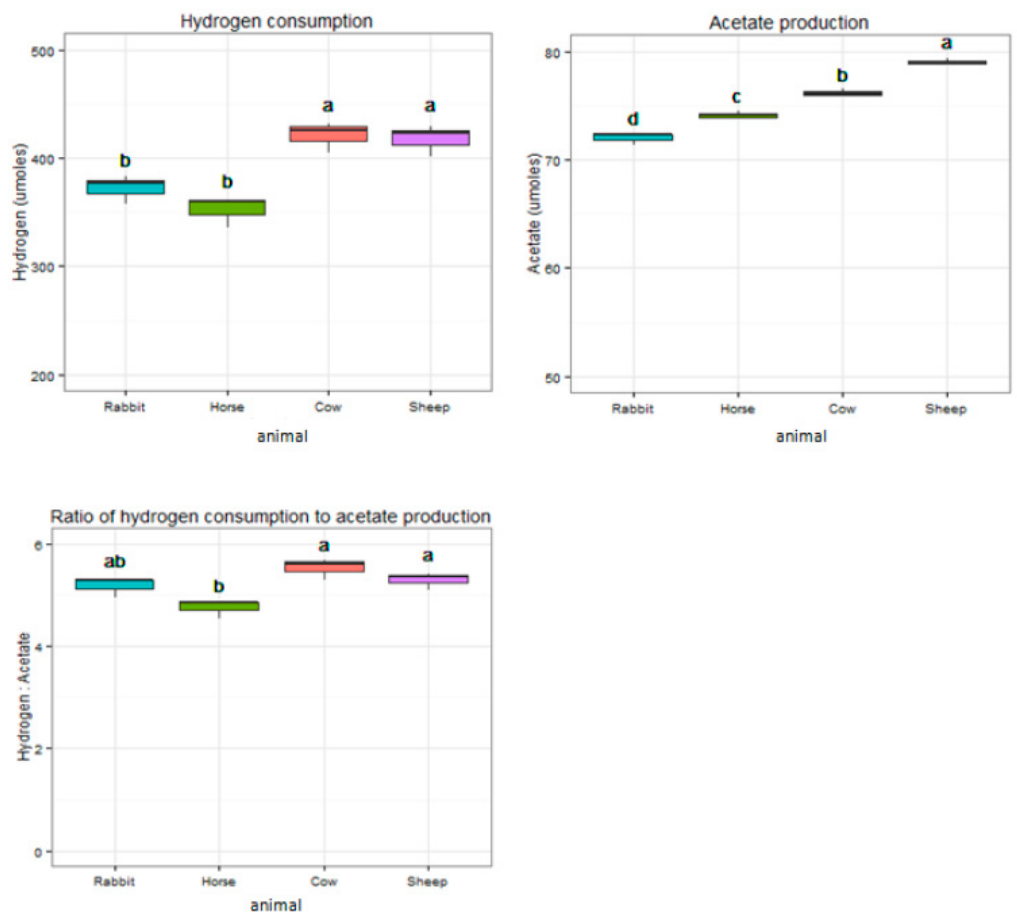
Figure 7. Different hydrogen consumption and acetate production characteristics of acetogen enrichment cultures from horse feces, rabbit cecum, and cow and sheep rumens during 48 h of incubation. Groups with different superscripts mean they differ significantly ( p < 0.05).